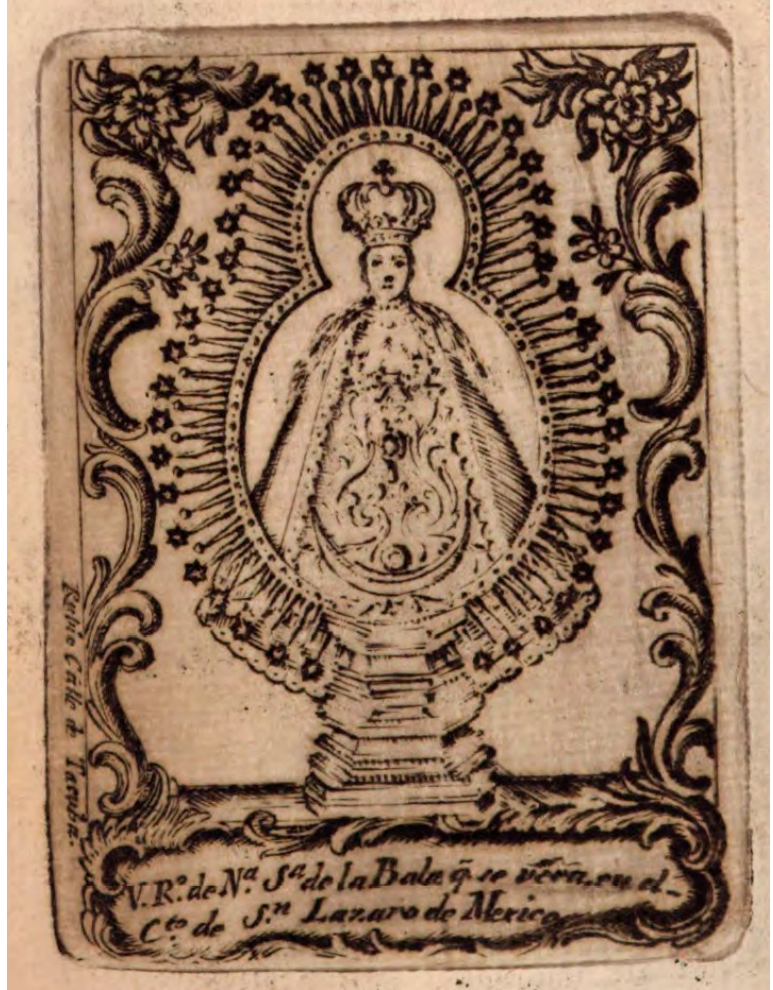
Figure 5. Augustín Rubio, Nuestra Señora de la Bala , ca. 1780. Engraving. Photograph used with Figure 5. August í n Rubio, Nuestra Señora de la Bala , ca. 1780. Engraving. Photograph used with permission of the Universidad Complutense de Madrid courtesy of HathiTrust. permission of the Universidad Complutense de Madrid courtesy of